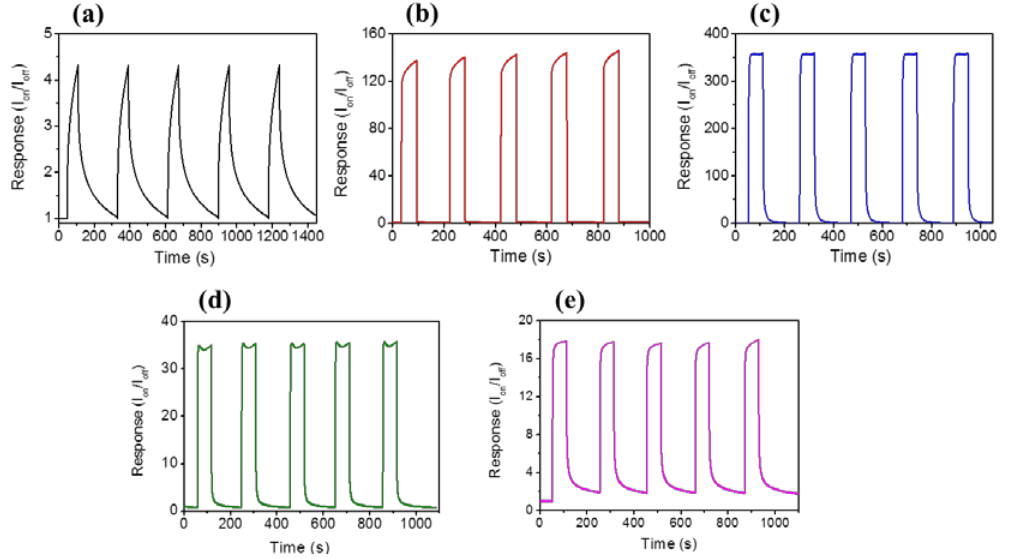
Figure 5. Photoresponse curves of various nanorods: ( a ) Pure ZnO. ( b )ZnO-ZnS (7 nm). ( c ) ZnO-ZnS (17 nm). ( d )ZnO-ZnS (32 nm). ( e ) ZnO-ZnS (46 nm).